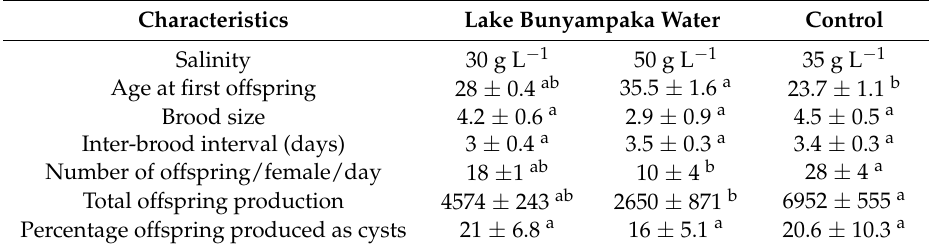
Table 2. Reproductive parameters determined for VC Artemia cultured in Lake Bunyampaka water of different salinities and in a control medium over 50 days of observation.